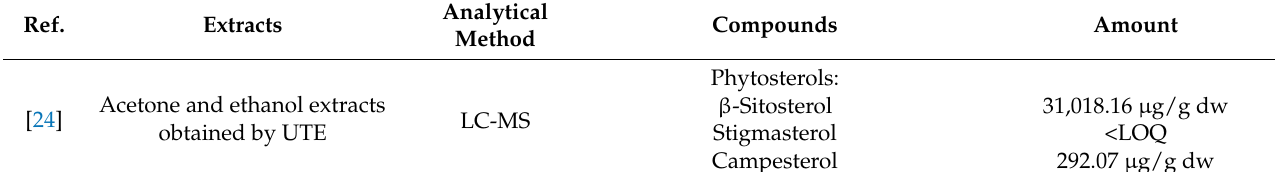
Table 3. Lipidic compounds identified and quantified in walnut